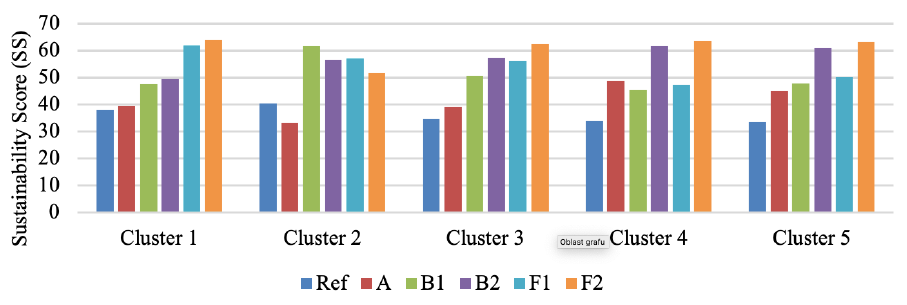
Figure 4. Sustainability scores of concrete mixes by cluster.